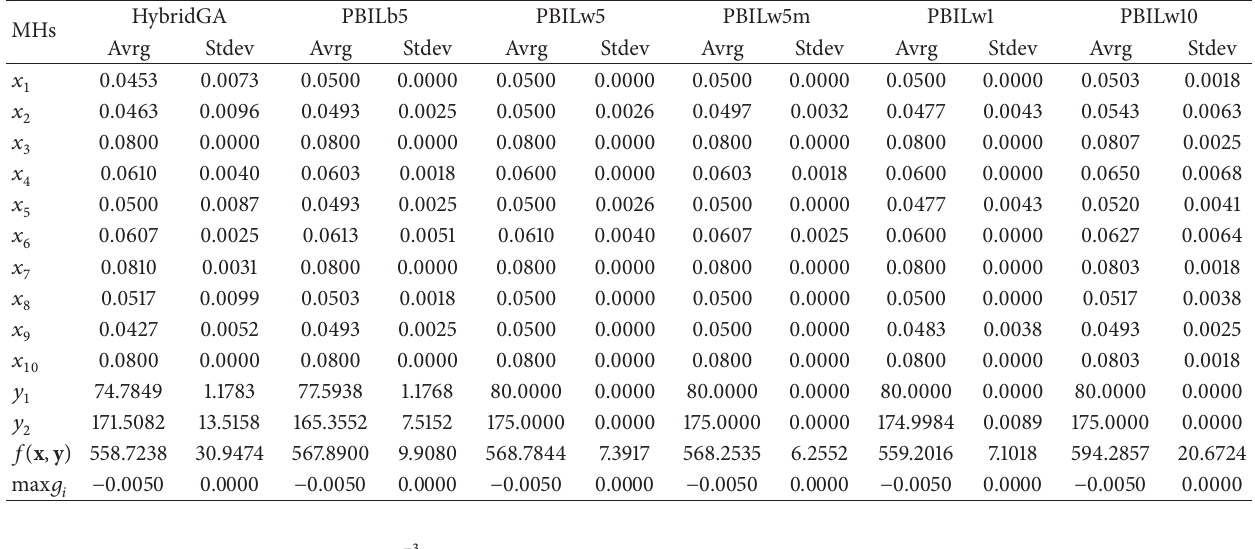
Table 2: Optimum results of AOP2.